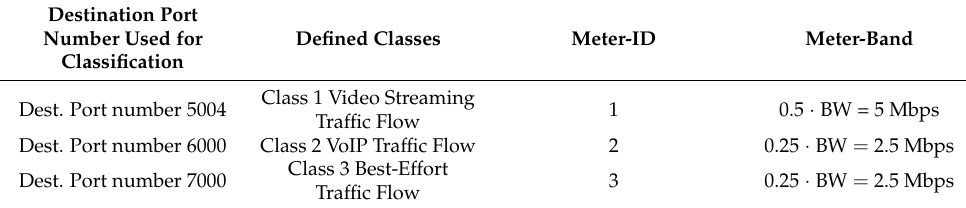
Table 5. Scenario 1 Initialization Phase.